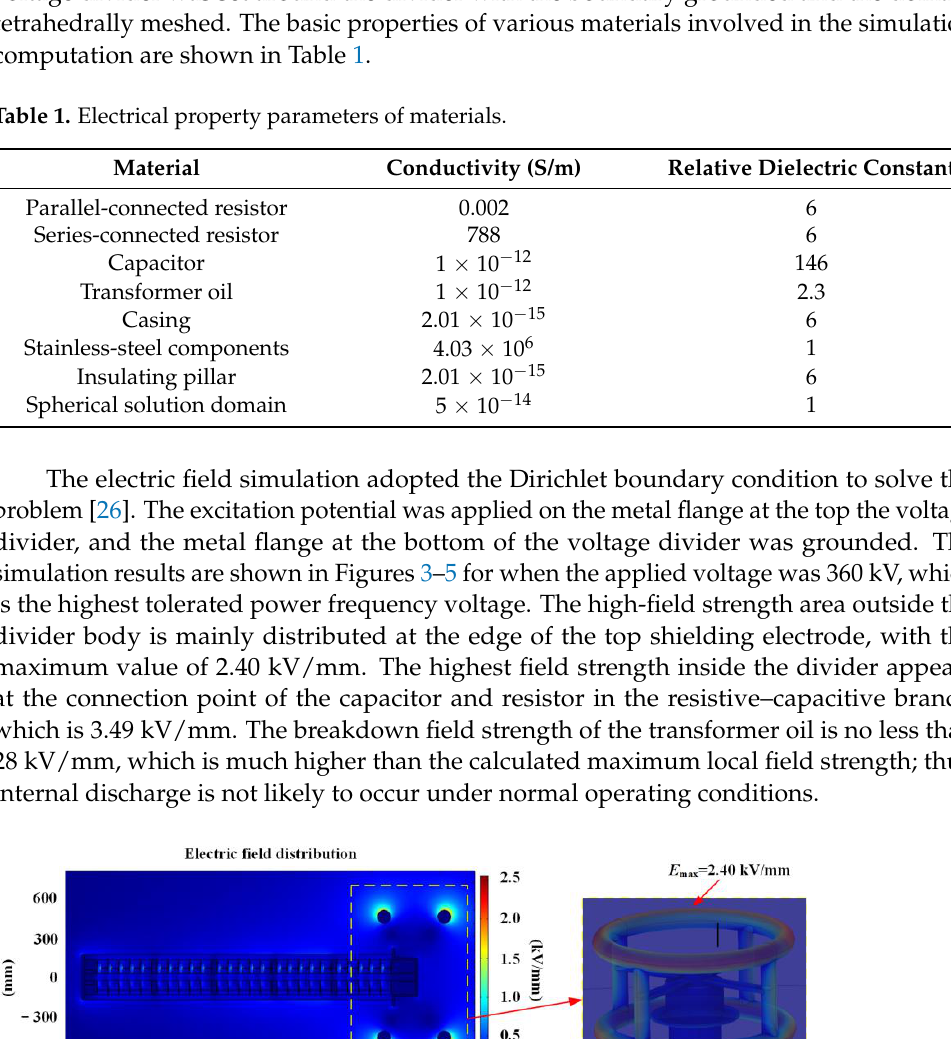
Figure 4. Electric field distribution of the unit in the high – voltage arm. Figure 5. Electric field distribution at the edges of the shielding electrodes. 2.3. Low-Voltage Arm In order to reduce the stray inductance of the low-voltage arm, multiple groups of resistors and capacitors were placed in parallel in the low-voltage arm, in which the com- ponents were compactly welded on a PCB (as shown in Figure 6). A non-inductive sym- metrical structure for both sides was adopted for the PCB [27]. In addition, resistor and capacitor chip elements with a small temperature drift and low inductance were used.